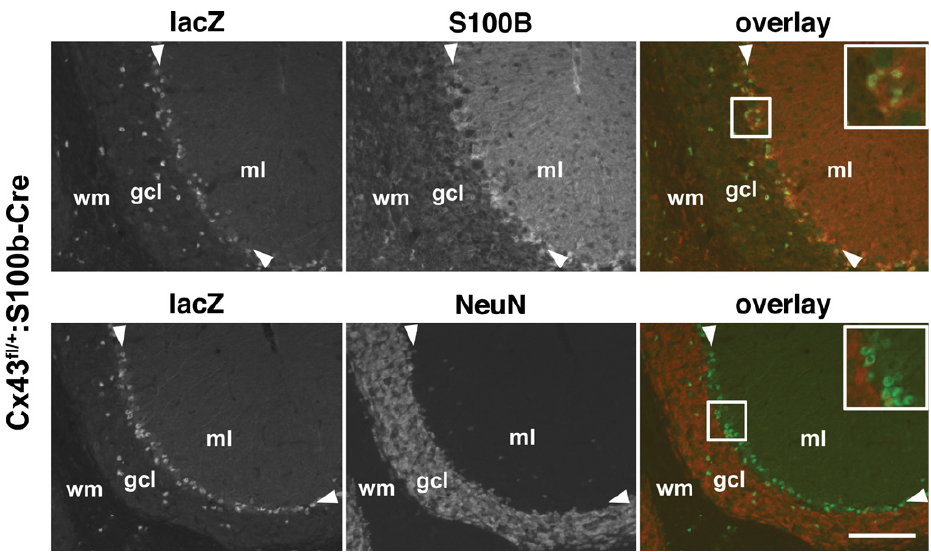
Figure 4. Cell-type specifi city of S100b-Cre -mediated recombination in the cerebellum of Cx43 fl / + :S100b-Cre mice. Double-immunofl uorescence analysis of parasagittal sections of the cerebellum. Nuclear lacZ immunoreactivity colocalized with S100B and not with NeuN corresponding to Bergmann glial cell bodies (magnifi ed in inserts) in the Purkinje cell layer (arrowheads) and astrocytes in the granule cell layer (gcl). ml, molecular layer; wm, white matter. Scale bars, 100 µm.